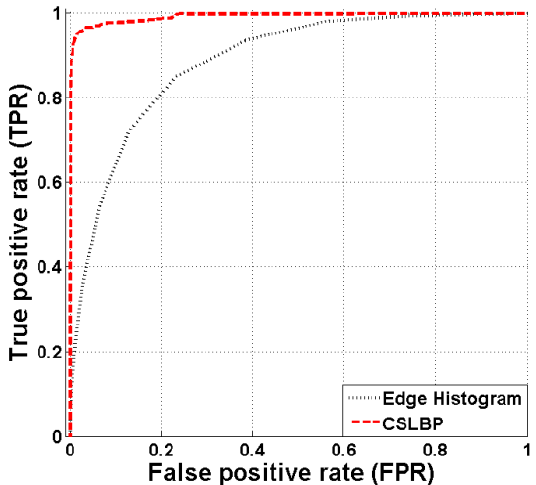
Figure 8. The ROC curve for tampering